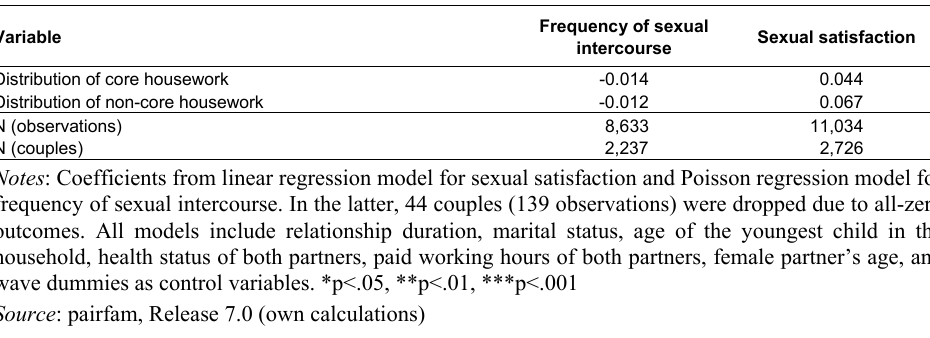
Table A.6 : Summary of fixed effects regression analyses estimating frequency of sexual intercourse and sexual satisfaction with different sample